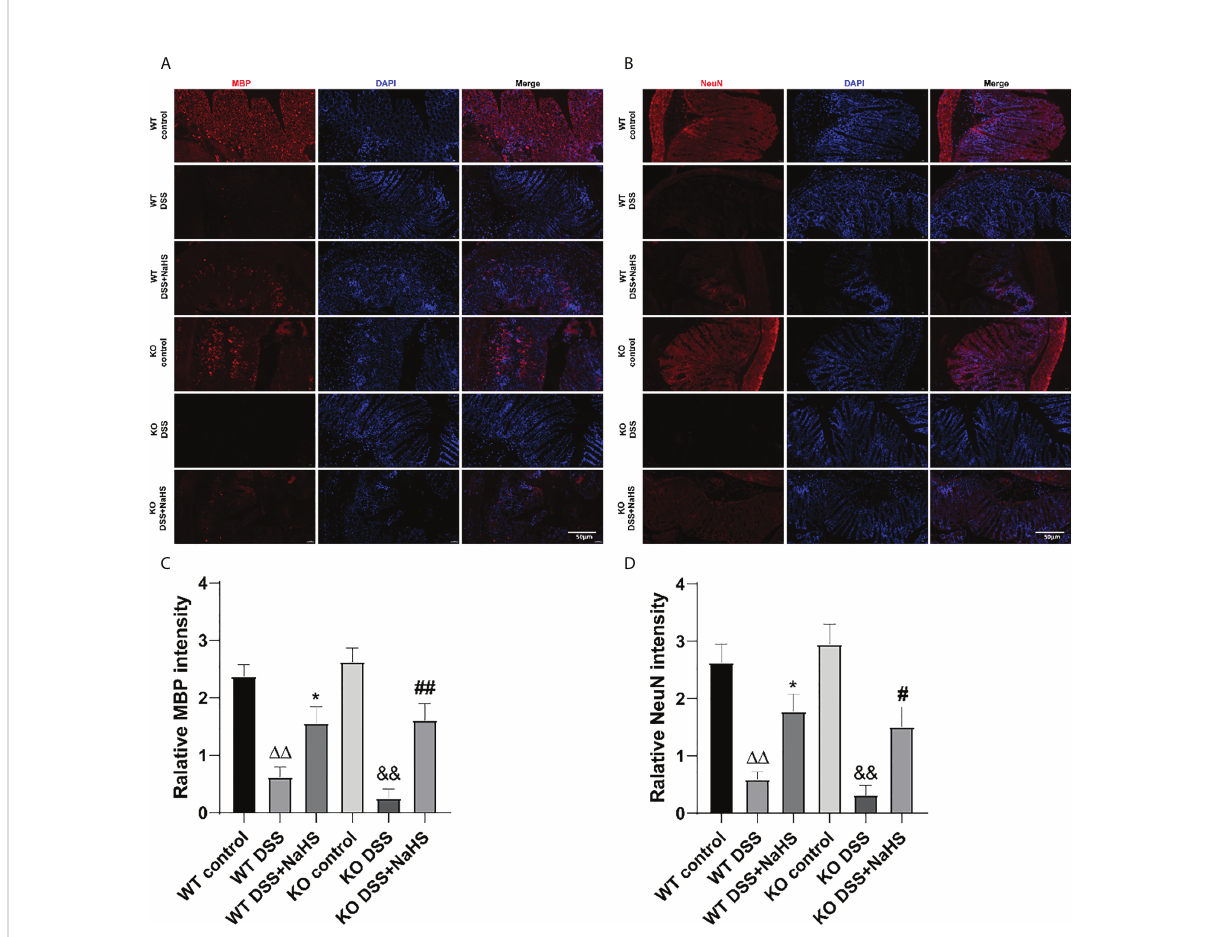
FIGURE 3 Effect of cystathionine- g -lyase (CSE)-produced hydrogen sul fi de (H2S) on the recovery of myelin sheaths and loss of neurons in colon of mice after dextran sodium sulfate (DSS). Scale bar=50 m m. (A) Myelin basic protein (MBP)-positive cells are red, 4 ’ ,6-diamidino-2-phenylindole (DAPI) nuclear staining is blue (200×magni fi cation). (B) Neuronal Nuclei (NeuN)-positive cells are red, DAPI nuclear staining is blue (200×magni fi cation). (C) Relative MBP intensity in the colon of mice. (D) Relative NeuN intensity in the colon of mice. DD P < 0.01 vs wild-type (WT) control group; *P < 0.05 vs WT dextran sodium sulfate (DSS) group; && P < 0.01 vs knockout (KO) control group; # P<0.05, ## P<0.01 vs KO DSS group